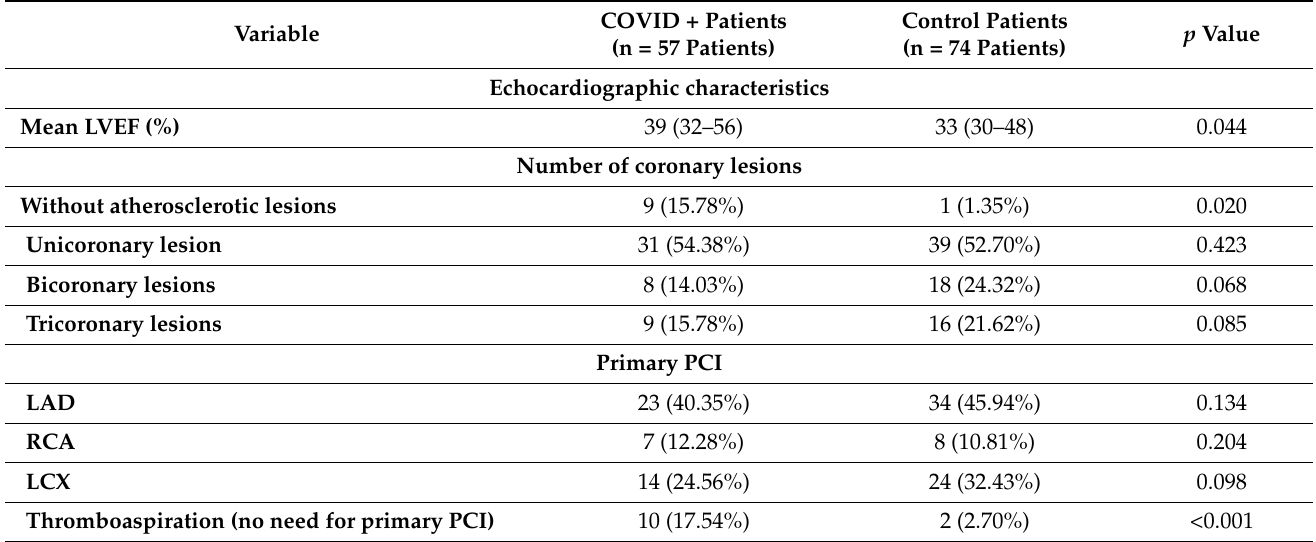
Table 3. Echocardiographic and procedural characteristics.